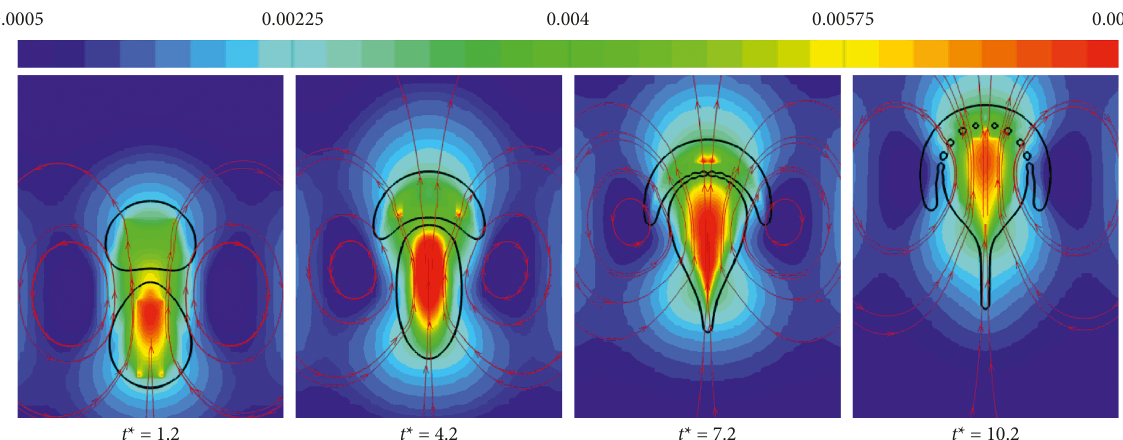
Figure 3: Coalescence process between two bubbles and corresponding flow field at Bo � 50, Ar � 1, ρ